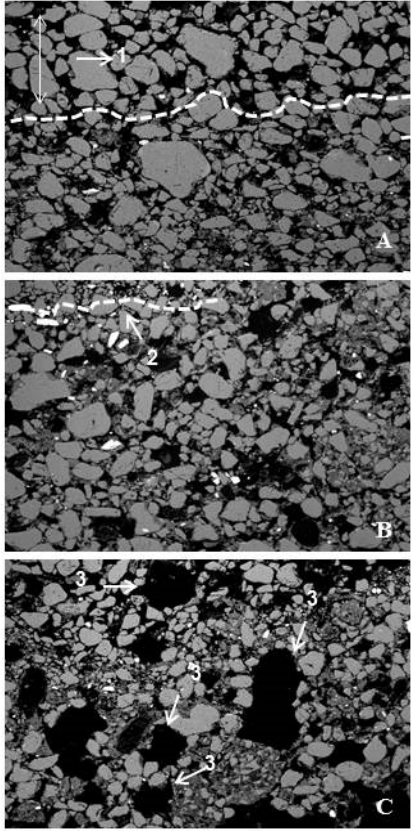
Figure 7. Thin sections vertically oriented and carbon-coated. Scanning electron microscope images with 35 × magnification. ( A ): CT—Conventional Tillage; ( B ): RT—Reduced Tillage; ( C ): NT—No-Tillage. Images ( A – C ) refer to maximum rainfall amount applied (80 mm). 1: crust formed, quartz grains arranged after rain applied; 2: lamination of accumulated fine material; 3: rounded pores (vesicles).